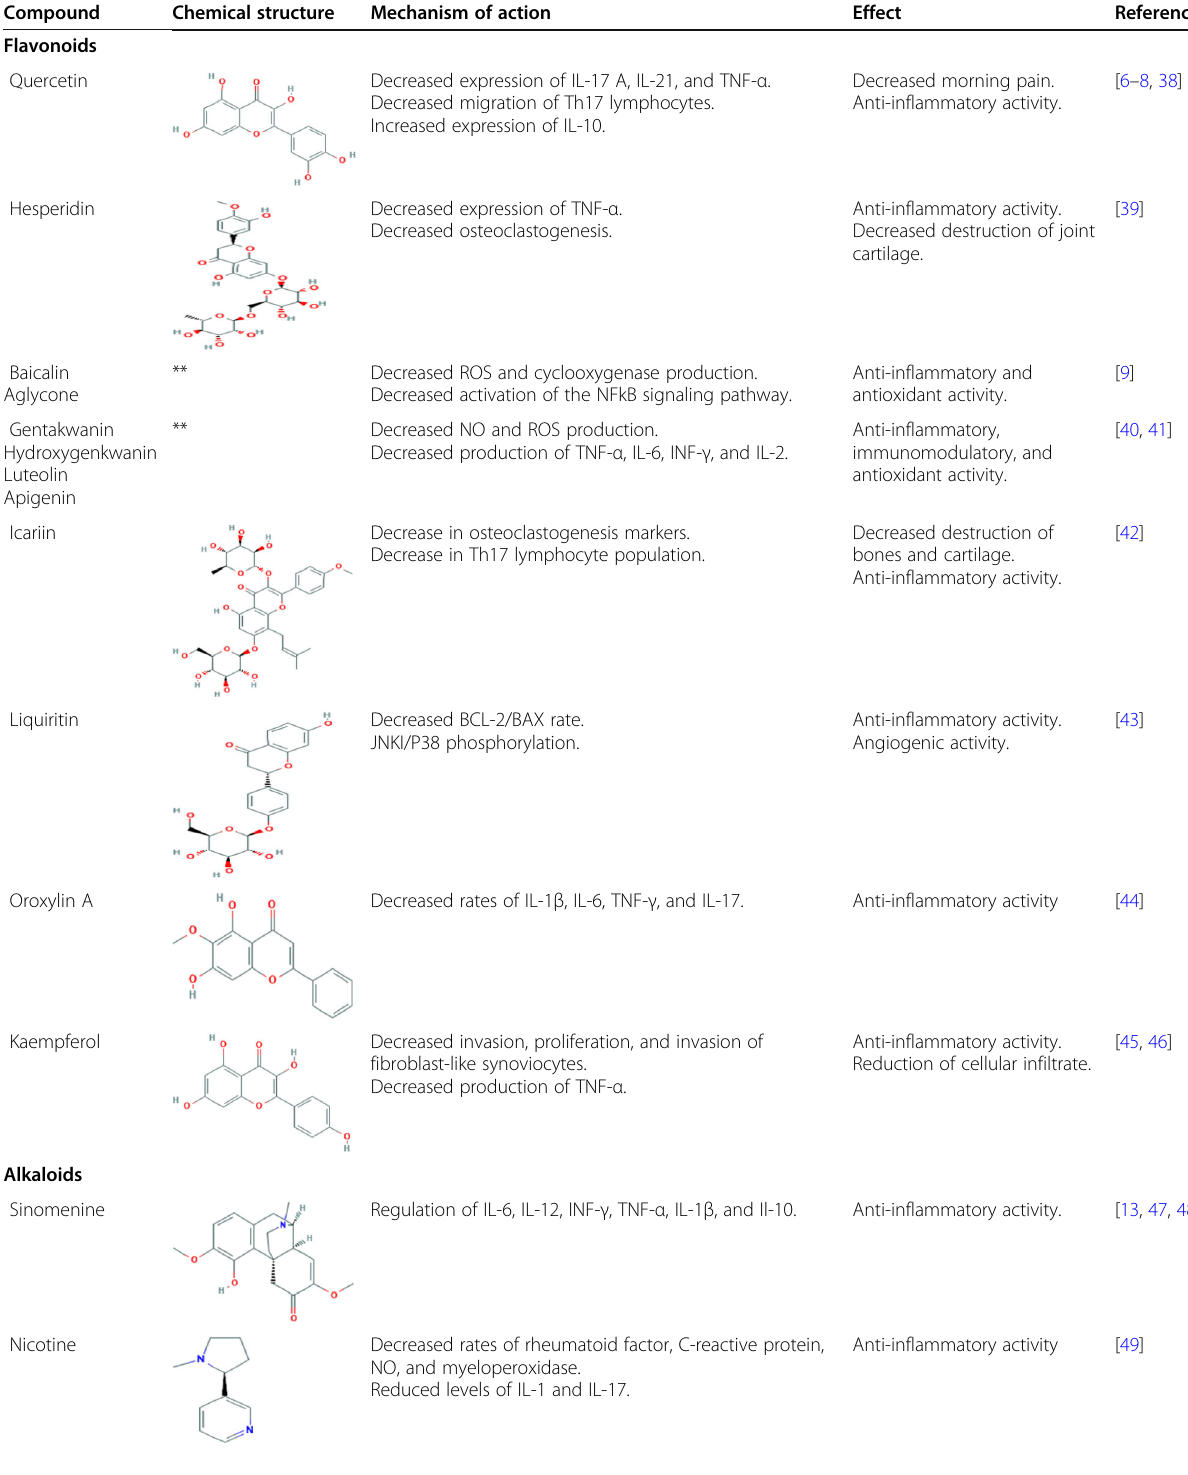
Table 2 Phytochemicals used in the treatment of rheumatoid arthritis